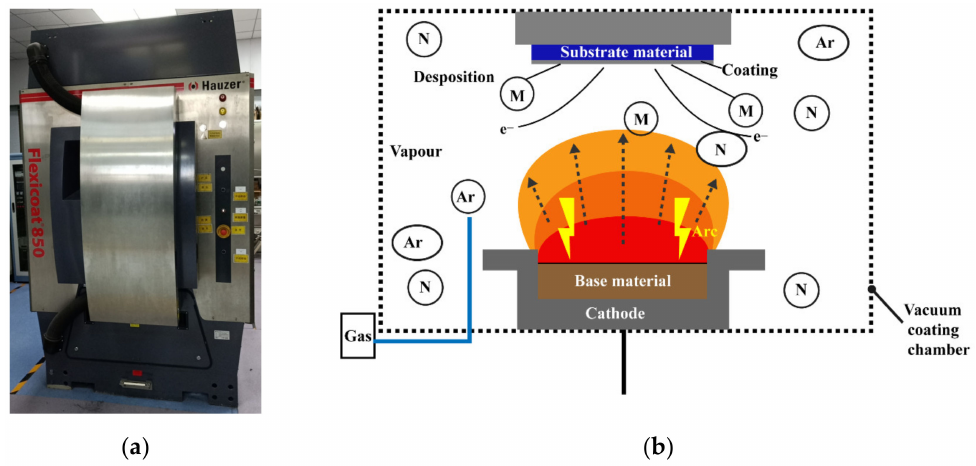
Figure 1. Coating preparation equipment and schematic. ( a ) Coating preparation system, and ( b ) preparation